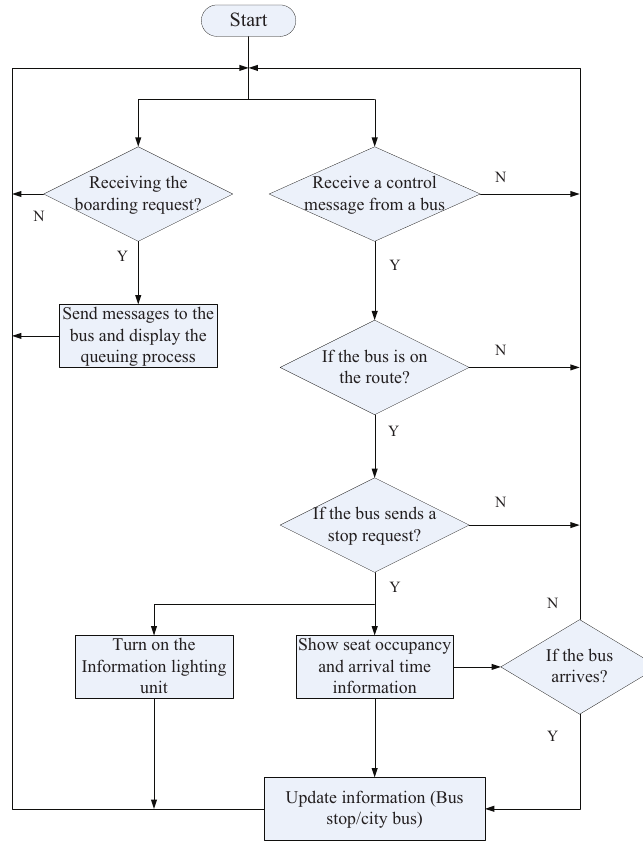
Figure 7. Information flow of interactive bus stops: “N” represents “No”; “Y” represents